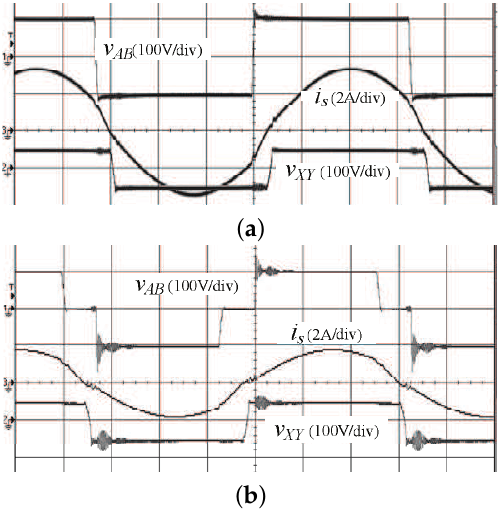
Figure 11. Experimental plots at V L = 48 V, output power: ( a ) P o = 200 W; ( b ) P o = 100 W. Time scale: 1.52 µ s/div.